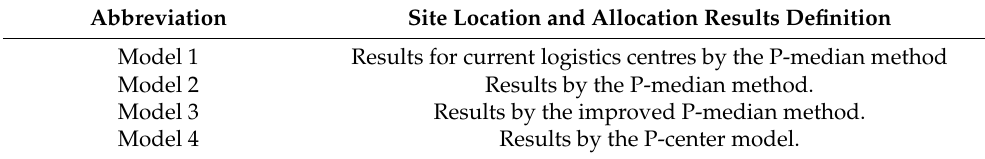
Table 5. Abbreviation for experimental